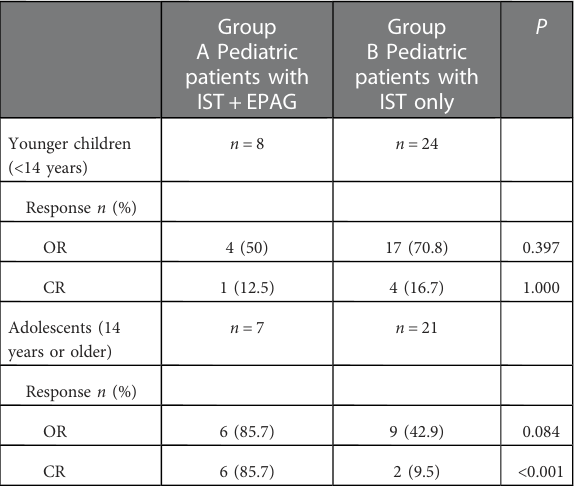
TABLE 3 Response at 6 months in younger children vs.